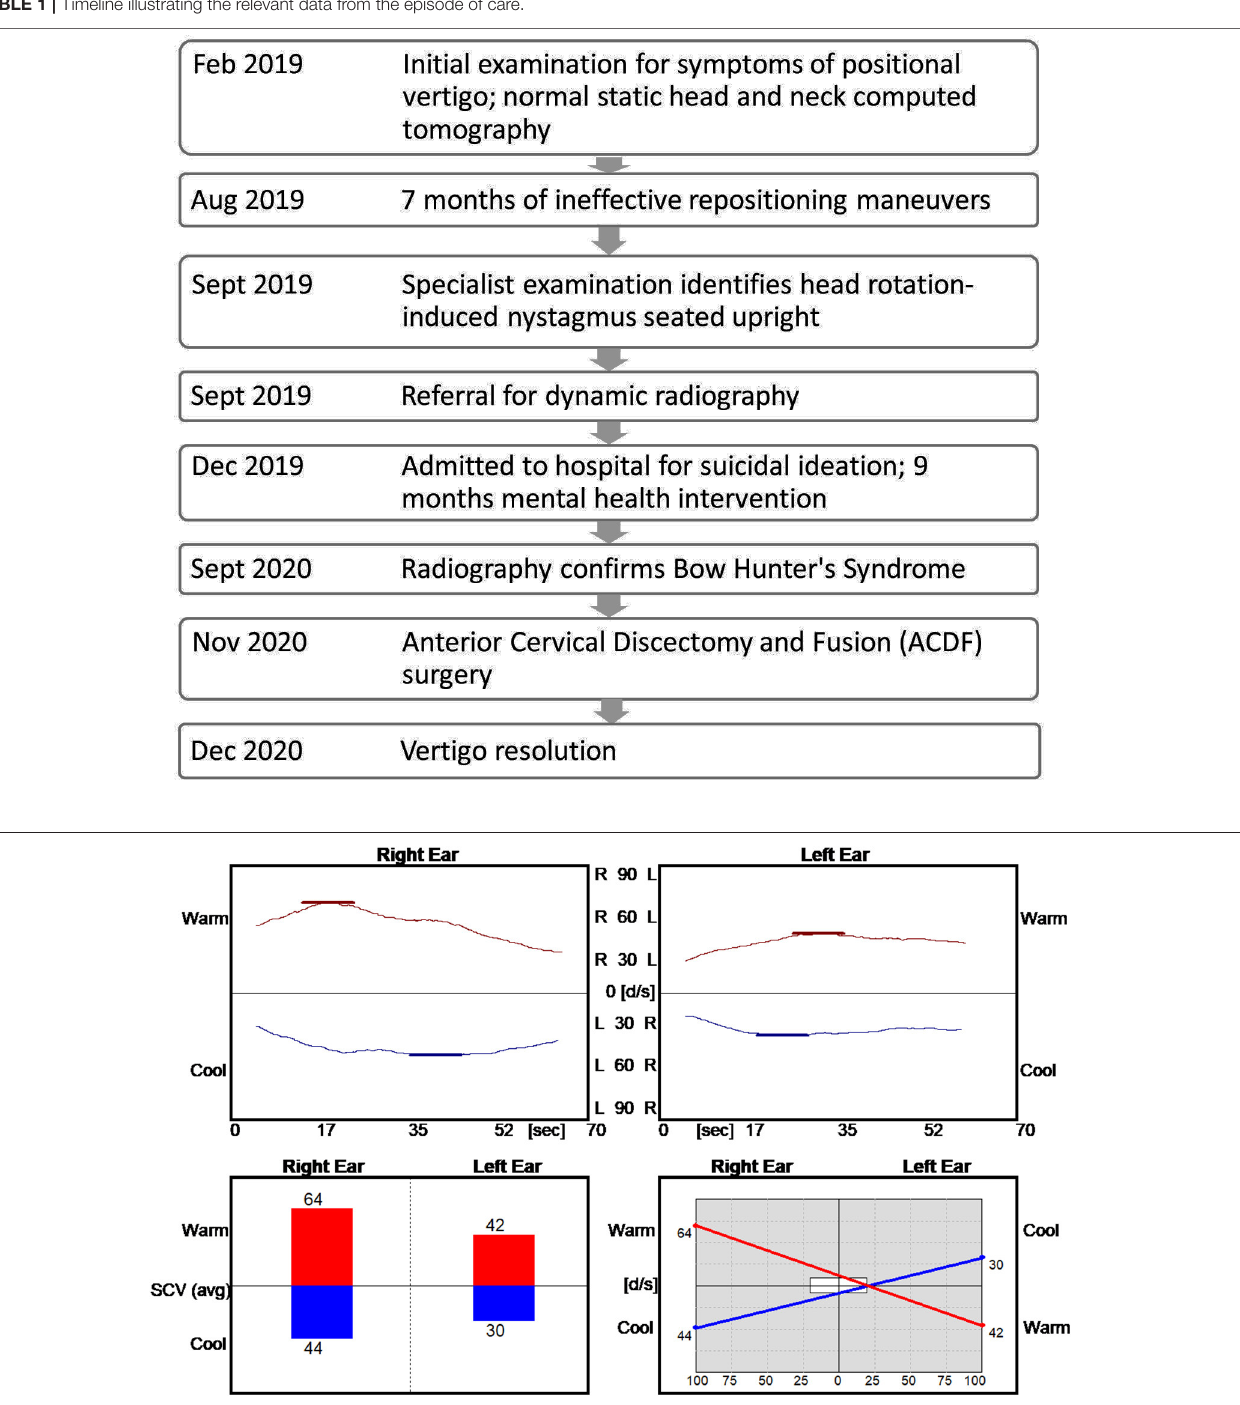
anatomy in consideration of surgical planning. The CTA revealed a severe stenosis of the V2 segment of the right vertebral artery at C4-5 secondary to uncovertebral joint arthropathy with osseous compression of the artery with right head